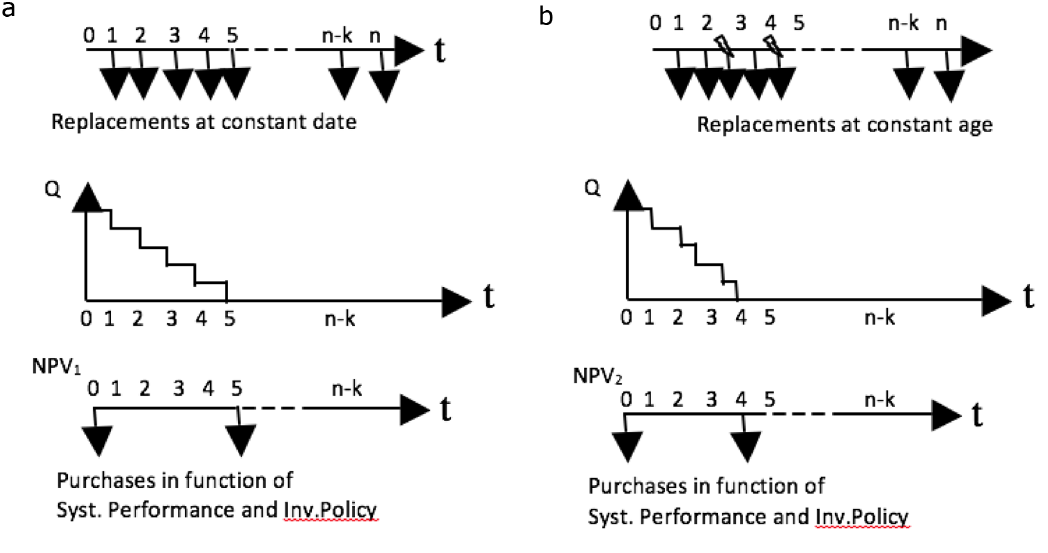
Figure 3. (a) Cash flow using PM (at constant date) and Continuous Review inventory model. (b) Cash flow using PM (at constant age) and Continuous Review inventory